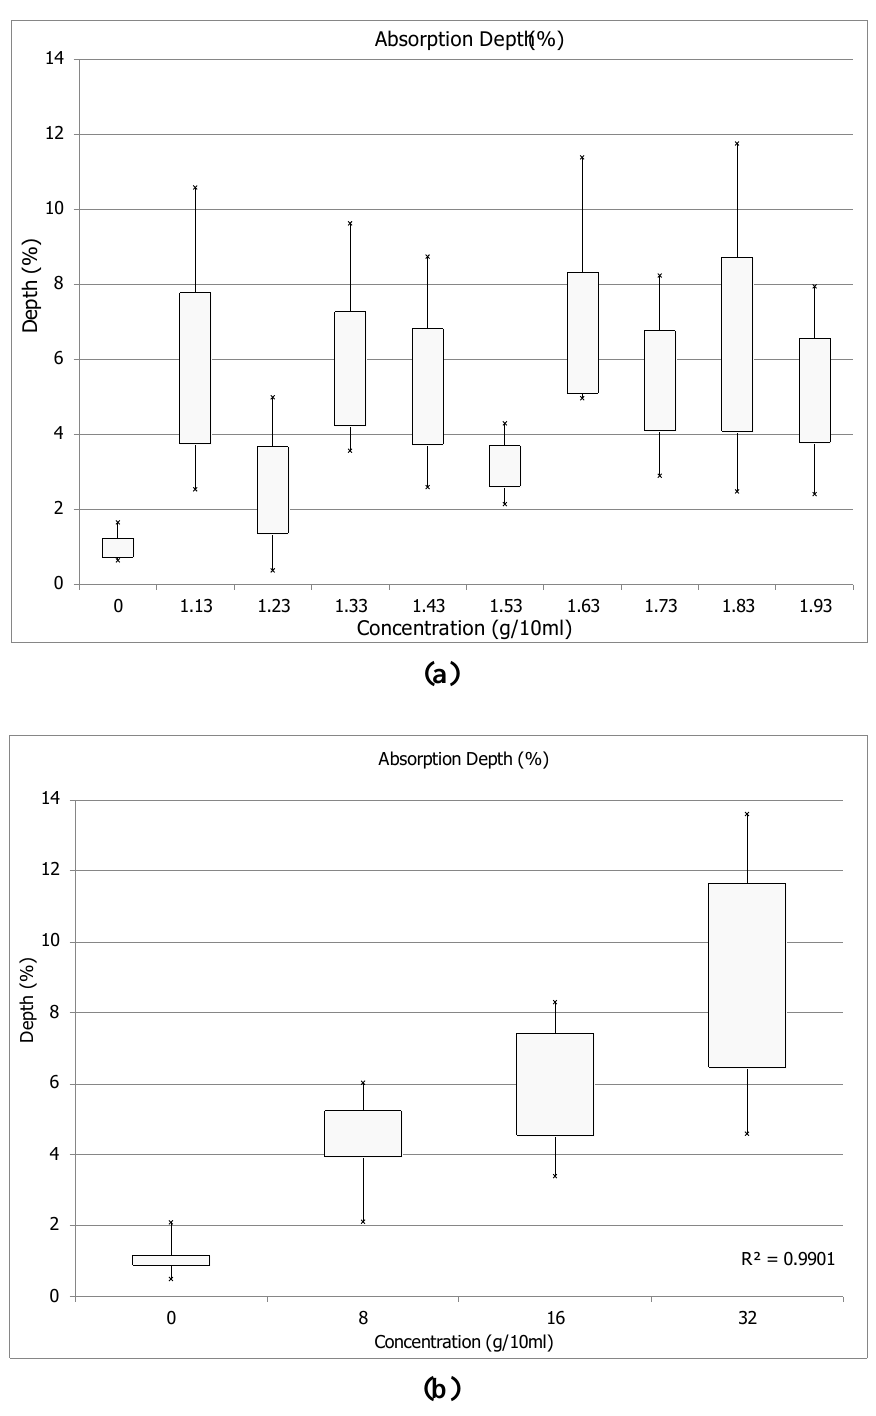
Figure 5. Change in absorption feature parameters-depth of the absorption, width and center, classes based on varying concentrations of added K fertilizer 0 to 32 g/10 mL for all samples and soil textural types: (a) Absorption band depth for 0 to 1.93 g/10 mL, (b) Absorption band depth for 0 to 32 g/10 mL, (c) Absorption width for 0 to 1.93 g/10 mL, (d) Absorption width for 0 to 32 g/10 mL, (e) Absorption center for 0 to 1.93 g/10 mL, (f) Absorption center for 0 to 32 g/10